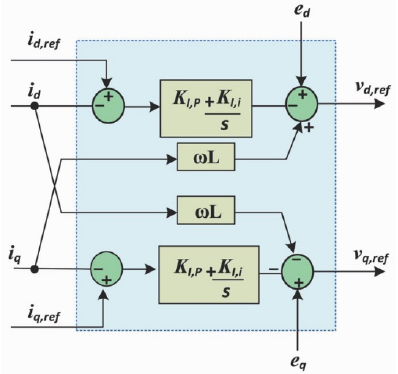
Figure 7. The control structure of an inner current controller. Adapted with permission from Ref. [26]. Copyright 2022,